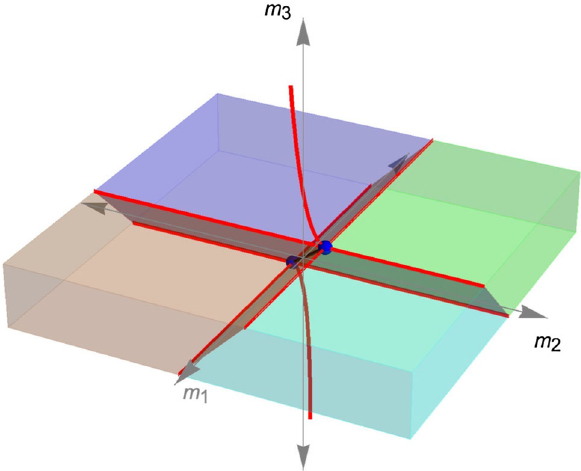
Fig. 15 The three-dimensional phase diagram of SU ( N ) k + p ψ 1 + q ψ 2 + ( F − p − q )ψ 3 with 0 ≤ k < F / 2 − ( p + q ) . ˜ σ c by the region in